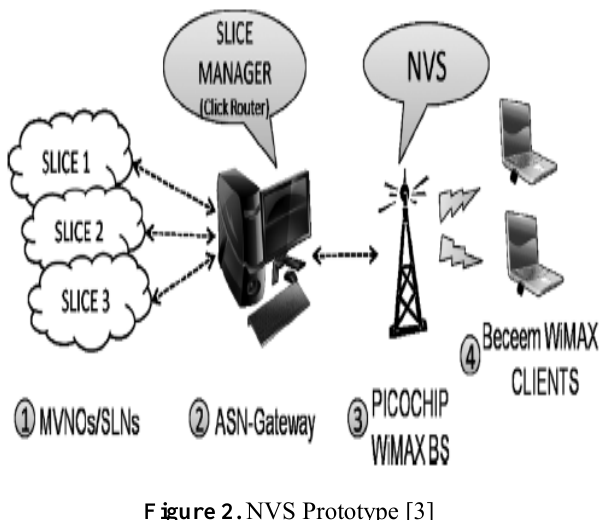
Figure 2. NVS Prototype